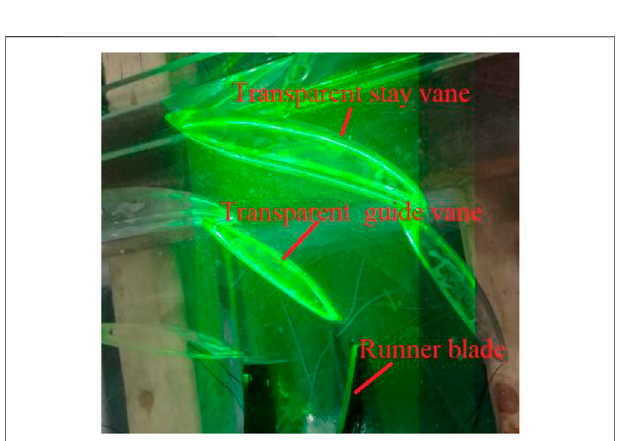
FIGURE 6 | Transparent stay vane and guide vane.